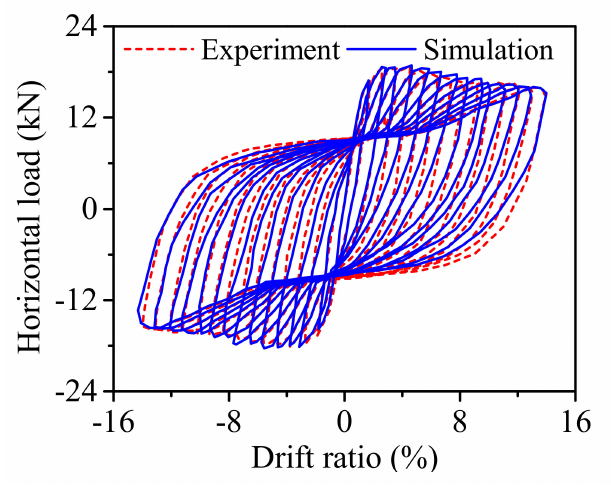
Figure 6. Numerical simulation results against test results.